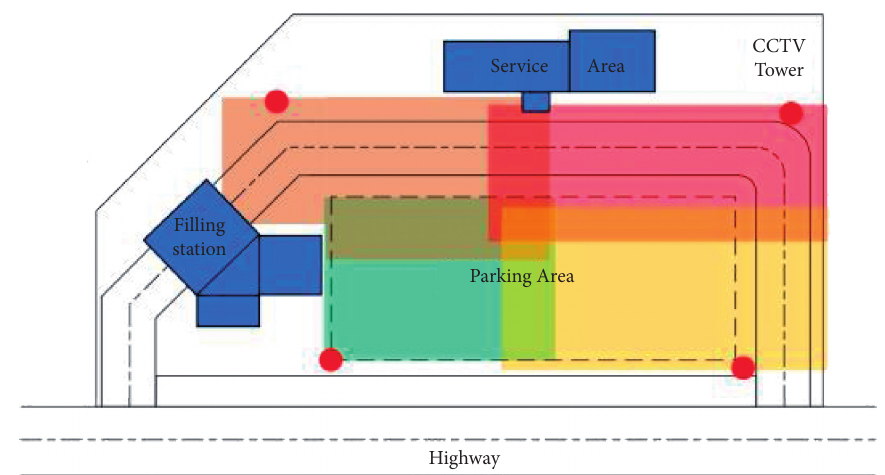
Figure 3: Overlapping areas of different cameras.